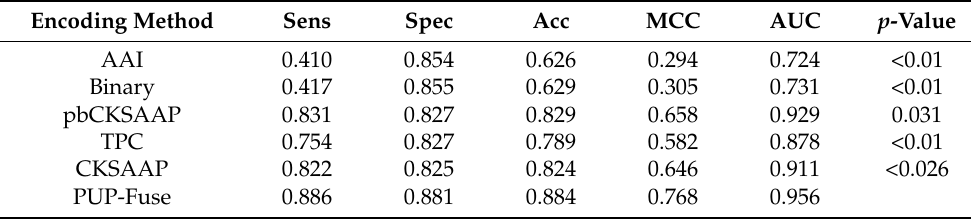
Table 2. Performance comparison among the single encoding-employing models and their combined models with feature selection on the training